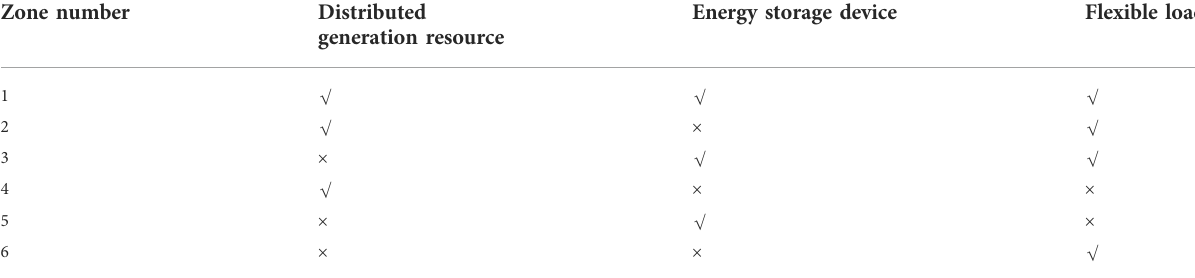
TABLE 1 Components inside the transformer supply zone.